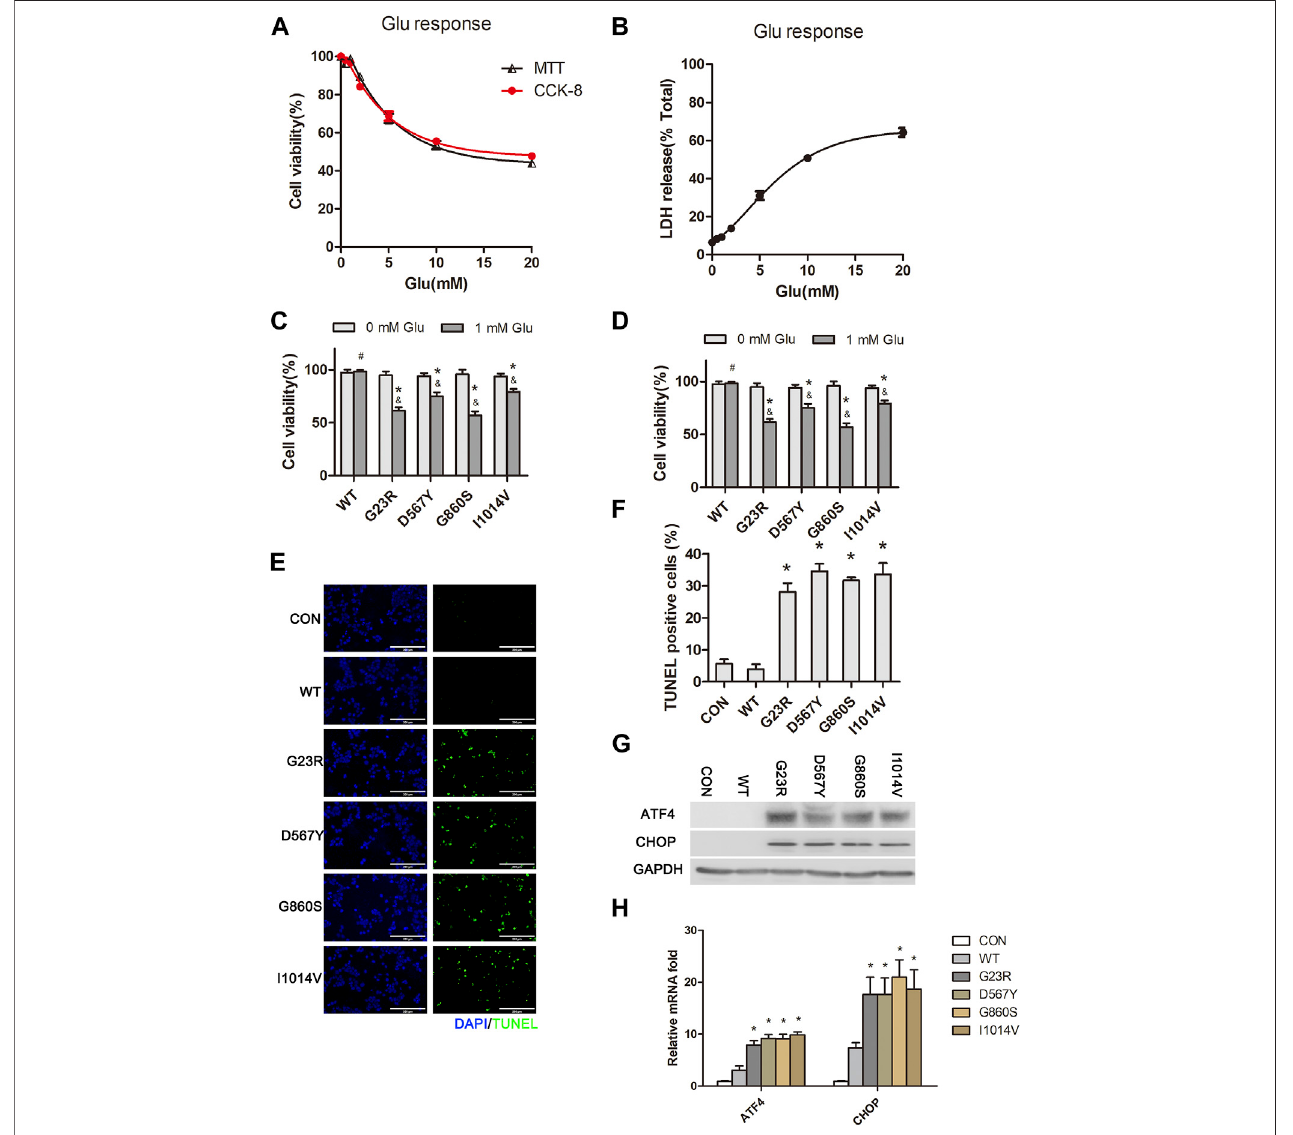
FIGURE 1 | SERCA2 mutants exacerbate hypo-glutamate-induced ERS and cell death in HT22 cells. (A,B) : MTT assay, CCK-8 assay (A) , and LDH release assay (B) show decreased cellular activity in a glutamate concentration-dependent manner in native HT22 cells. (C,D) : CCK-8 assay (C) and LDH assay (D) show SERCA2 mutants exacerbated hypo-glutamate-induced cell death. * p < 0.05 compared with respective 0 mM glutamate stimulation. # p > 0.05 compared with respective 0 mM glutamate stimulation. & p < 0.05 compared with WT in 1 mM glutamate stimulation, respectively. (E,F) : Representative images (E) and summary data (F) show increased cell apoptosis of SRCA2 mutants under hypo-glutamate stimulation byTUNEL staining. * p < 0.05 compared withWT group, respectively.Scale bar, 200 µm. (G,H) : Increased expression of ERS marker of indicated proteins (G) and mRNAs (H) under hypo-glutamate stimulation by Western blotting, real-time qPCR, respectively. * p < 0.05 compared with WT